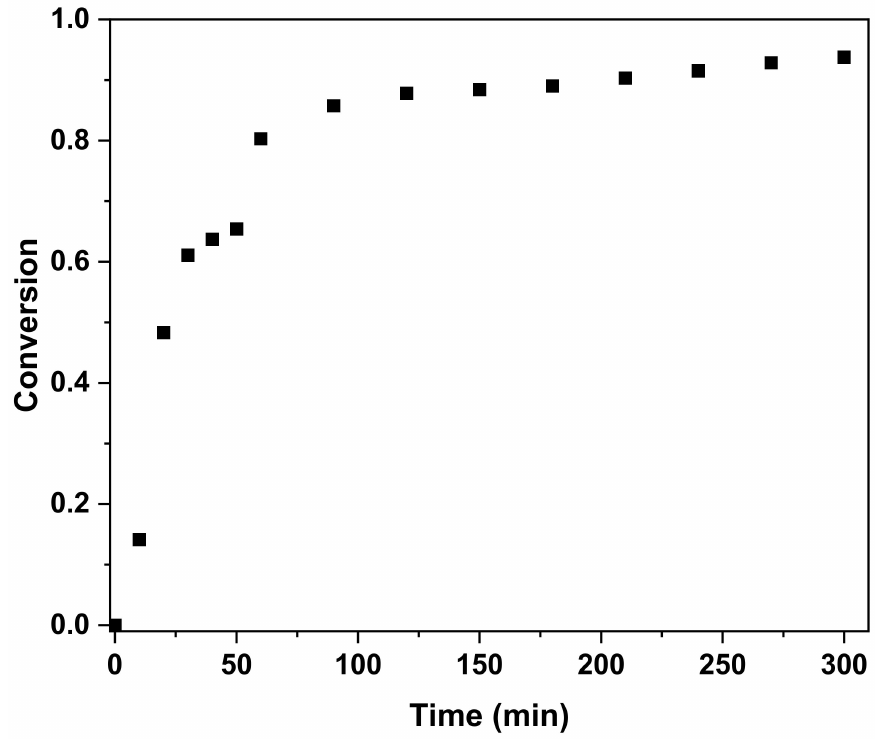
Figure 6. Cure conversion of the DGEBA–IPDA system heated at 60 ◦ C for 3 h and then at 75 ◦ C for 2 h.